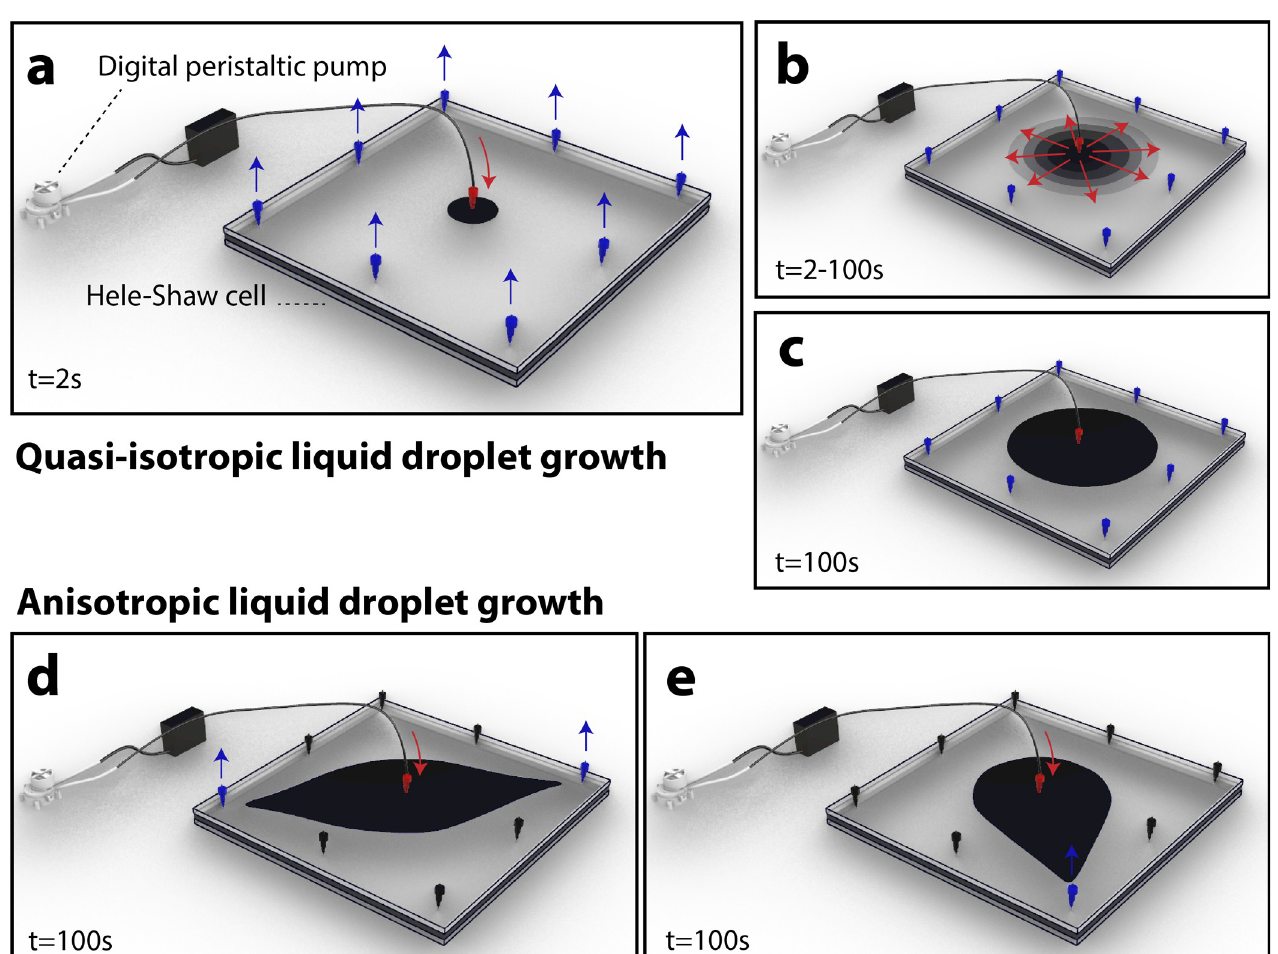
Fig 1. Working principle of active droplet formation. (a-c) Digitally-driven quasi-isotropic pigment injection within Hele-Shaw fluid cell. (d-e) Anisotropic droplet formation over time achieved through dynamic control of flow field.